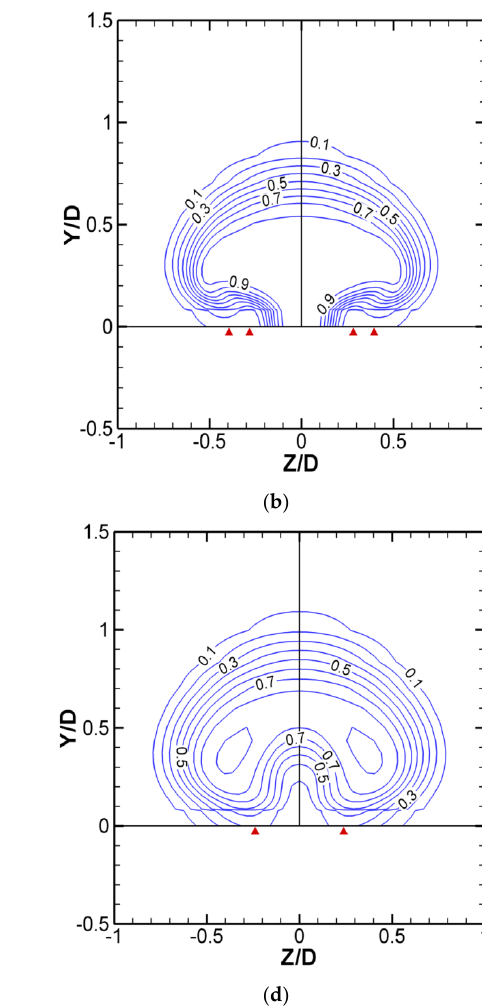
Figure 14. θ contours on Y-Z planes before liftoff. ( a ) X/D = 0; ( b ) X/D = 0.5; ( c ) X/D = 1; ( d ) at liftoff position.